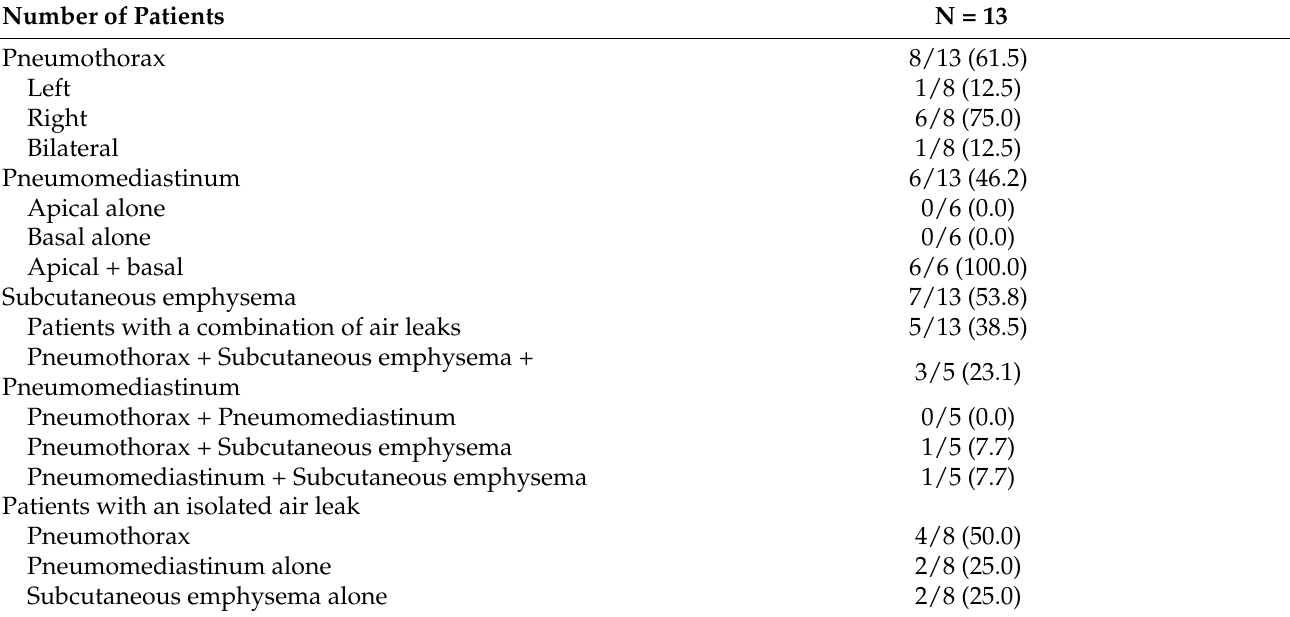
Table 2. Air Leak Characteristics in Patients with an Air